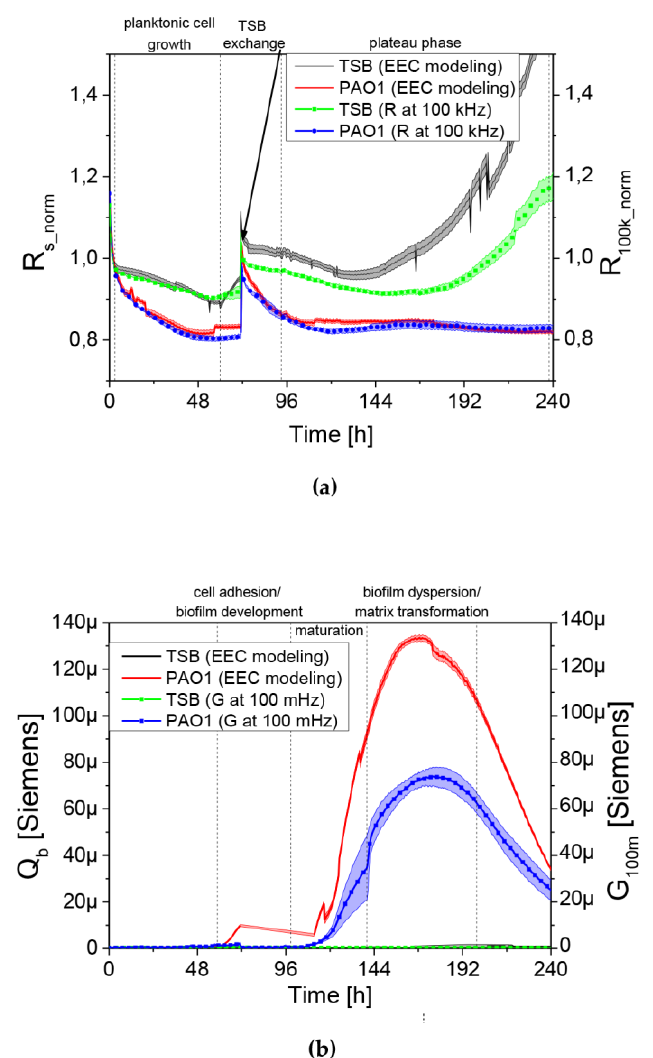
Figure 6. ( a ) Comparison of the normalized resistance parameter measured by the method using EEC model (parameter R s_norm —left axis) with the measurement at one frequency of 100 kHz (parameter R 100k_norm —right axis); ( b ) Comparison of the conductance parameter for the method using EEC model (parameter Qb —left axis) the measurement at 100 mHz (parameter G 100m —right axis).